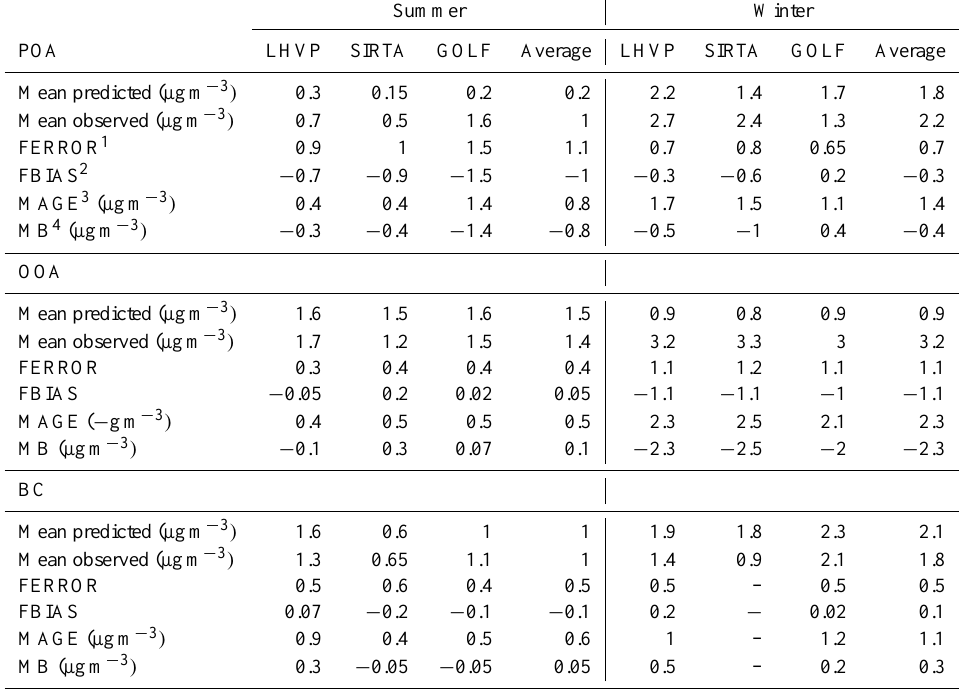
Table 3. Prediction skill metrics of PMCAMx against observed hourly